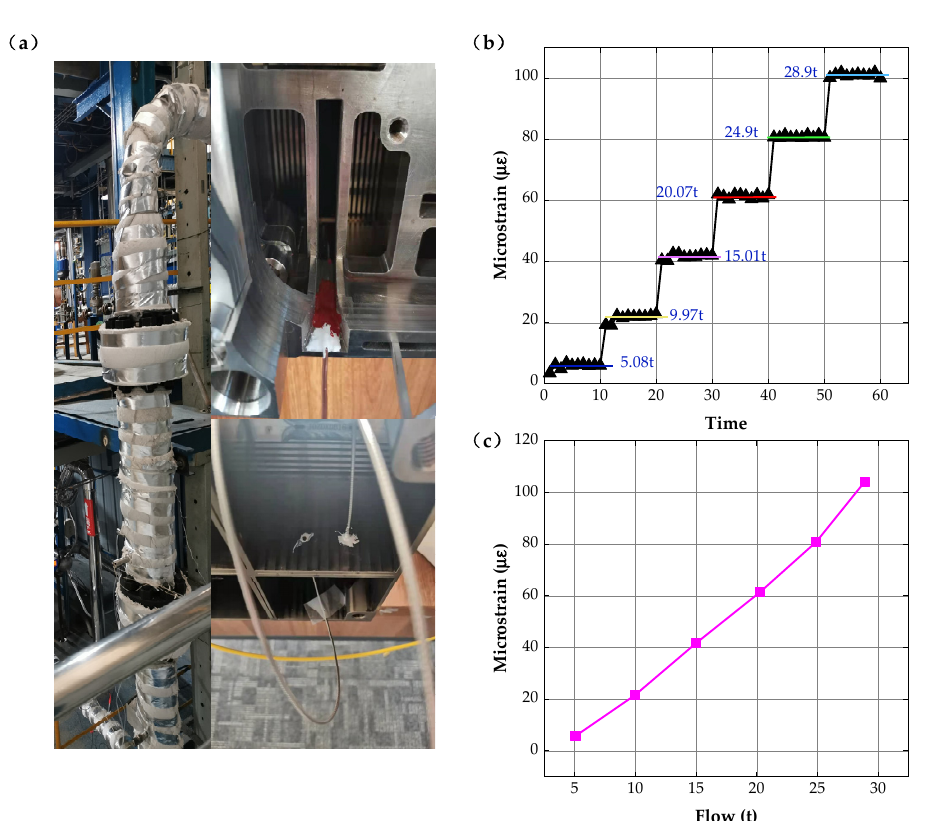
Figure 7. Thermal-hydraulic experiments. ( a ) Experimental environment, ( b ) microstrain variation diagram, and ( c ) strain-flow relationship diagram.